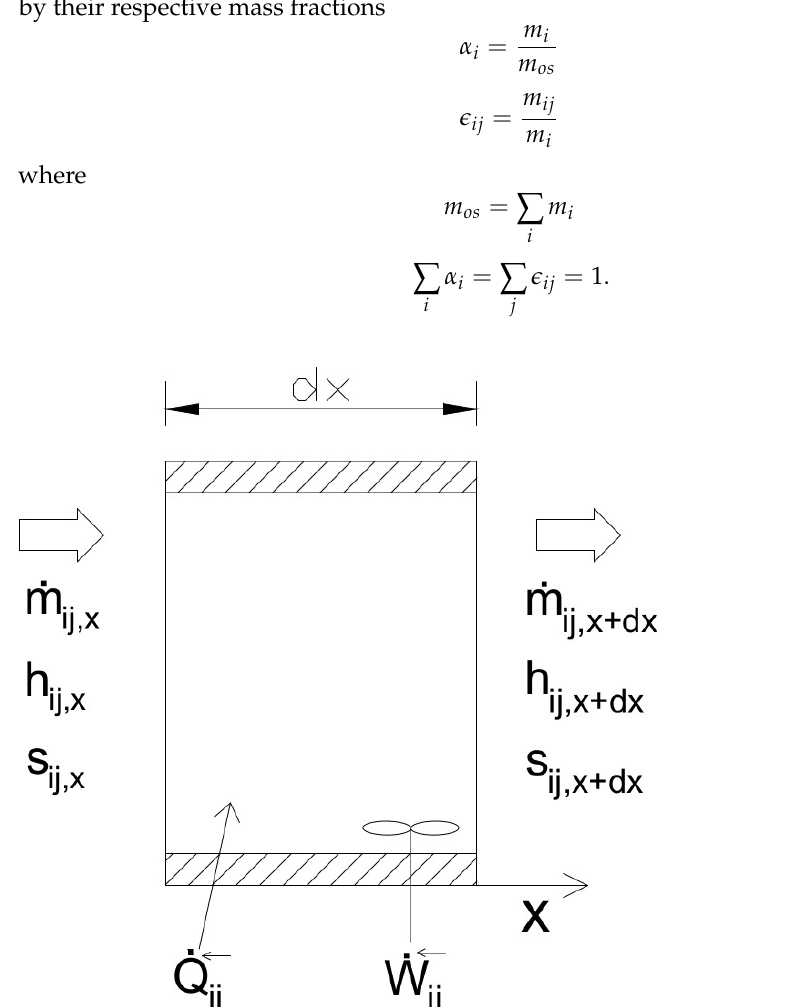
Figure 2. The two-fluid multispecies model of the i-phase formed by the dispersed